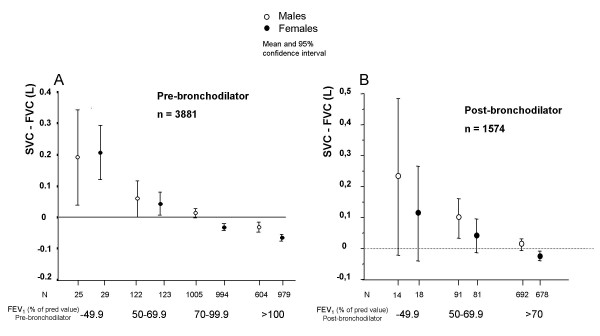
A. Difference between pre-bronchodilator slow (SVC) and forced (FVC) vital capacity related to FEV1 as percent of predicted value prior to bronchodilatation in 3881 smokers. Due to difficulties in taking instructions or technical errors data from 6 spirometries were not included in the analyses which thus are based on 3881 and not 3887 smokers. B. Difference between post-bronchodilator slow (SVC) and forced (FVC) vital capacity related to FEV1 as percent of predicted value after bronchodilatation in 1574 smokers with a pre-bronchodilator FEV1/VC -ratio below 0.75. Due to unacceptable measurements or technical errors data from 3 spirometries were not included in the analyses which thus is based on 1574 and not 1577 smokers.